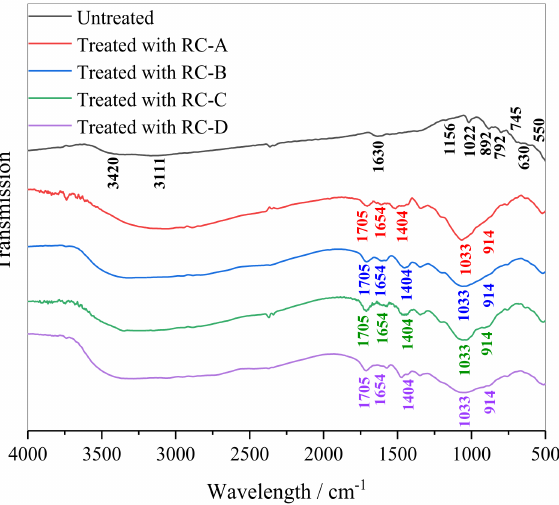
Figure 7. FT-IR spectra of untreated rusty steel sheet and steel sheet treated with RC-A, RC-B, RC-C, and